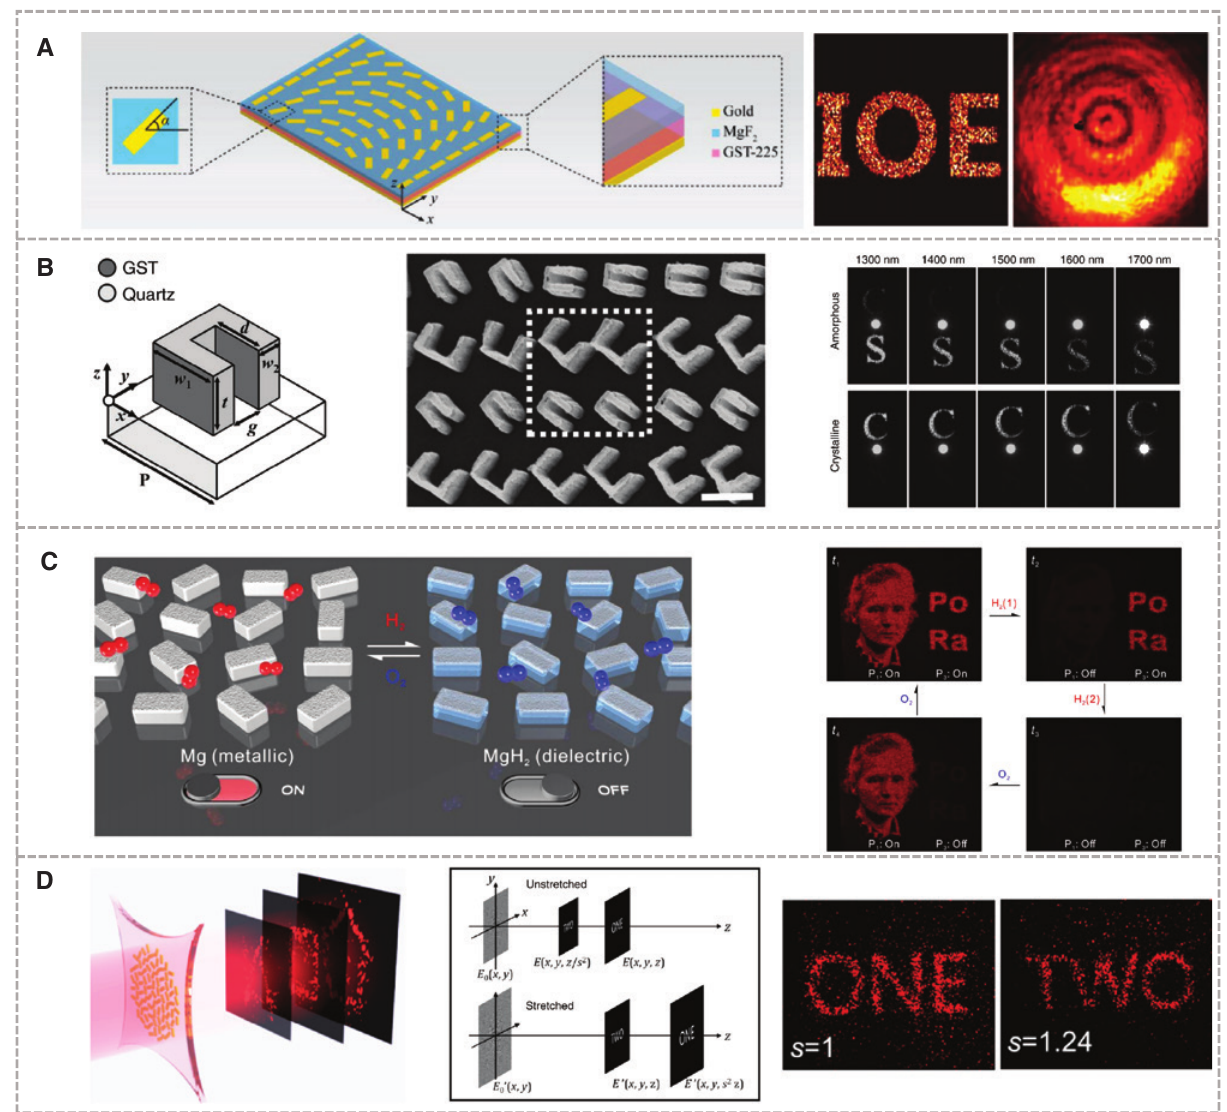
Figure 4: Tunable and dynamic metahologram. (A) Plasmonic metasurface for switchable photonic spin-orbit interactions based on GST [80]. The left image shows the material and schematic diagram for the proposed structure. The right two images are captured holographic images from the fabricated sample, which only show the operation on the amorphous state of GST. (B) GST-nanostructured metasurface for wavefront switching [60]. The left image shows the C-shaped meta-atom for the unit cell of the proposed structure. The middle image shows the SEM image of the sample. Scale bar is 500 nm. The right images are measured results according to the states of GST meta-atom and selected wavelengths. (C) Addressable metasurfaces for dynamic hologram and optical information encryption [81]. The left image shows the mechanism of proposed plasmonic metasurface. The right shows how the holographic image from the proposed structure can be dynamically tuned by hydrogen and oxygen. (D) Strain multiplexed metasurface hologram by stretchable substrate [91]. The left and middle images show the schematic of the proposed scheme. The two images on the right are captured holographic images by varying the pulling force to